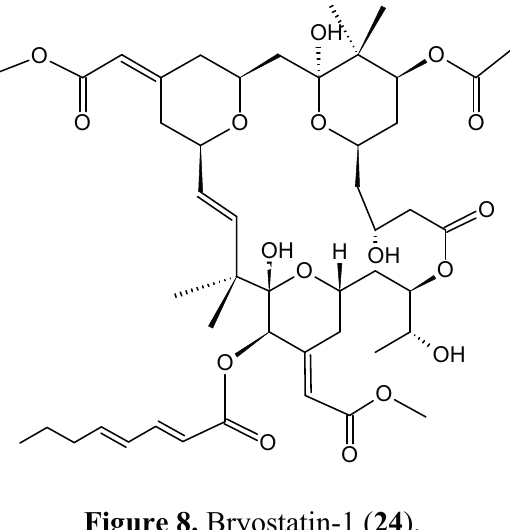
Figure 8. Bryostatin-1 ( 24